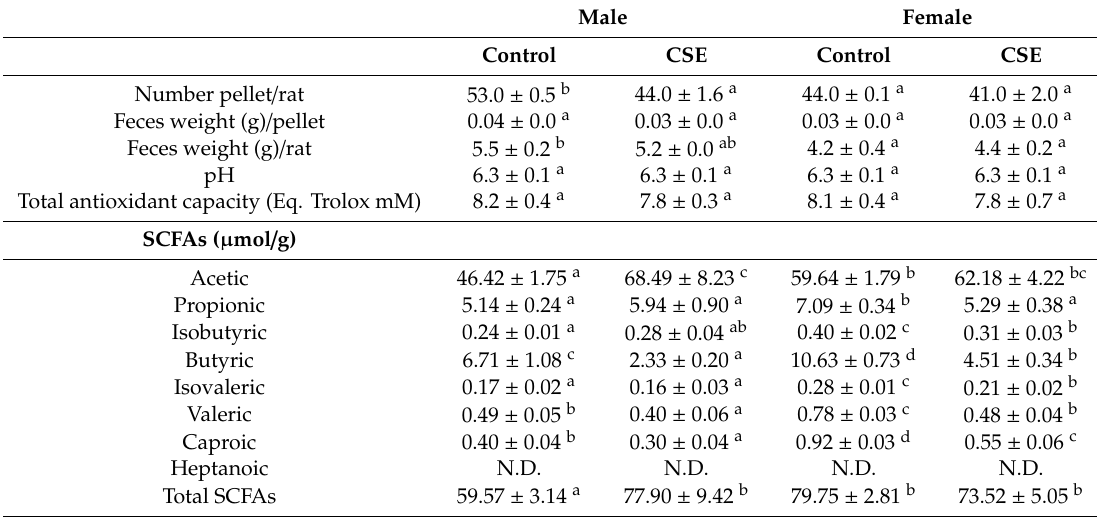
Table 6. Analyses of feces generated during 24 h from control rats ( n = 15) and rats treated with CSE (1 g / kg) ( n = 15) collected on the last day of the